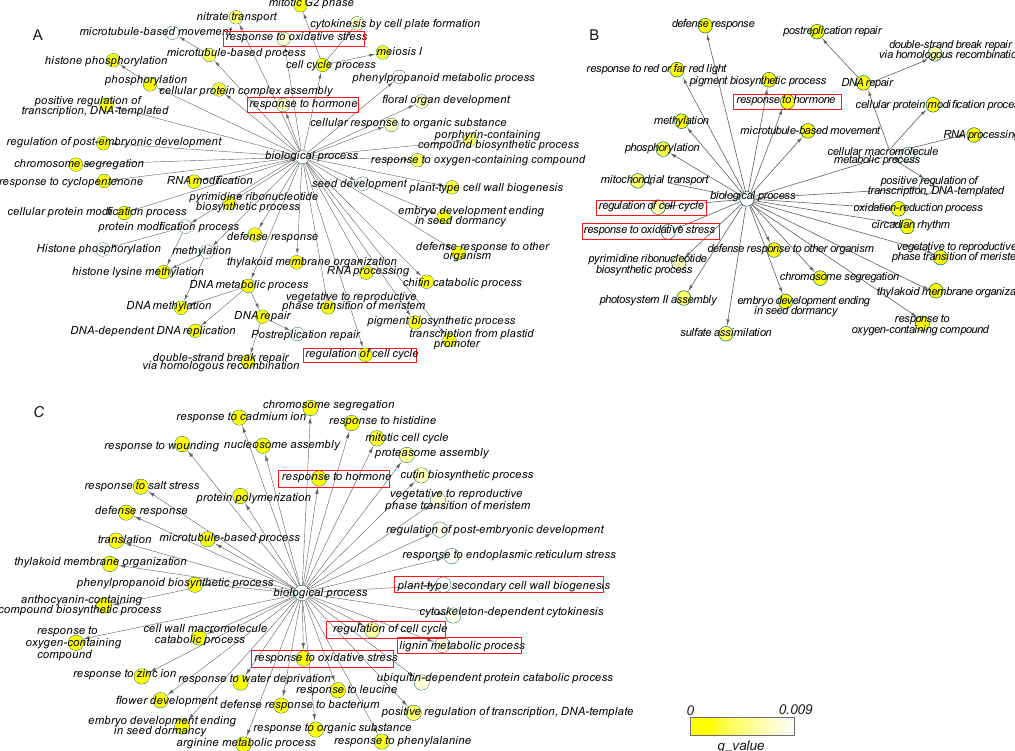
Figure 2. GO enrichment of DEGs during the graft process. ( A ) Significantly enriched GO terms between 8 days and 0 days; ( B ) significantly enriched GO terms between 15 days and 0 days; ( C ) significantly enriched GO terms between 30 days and 0 days. Bubbles represent the significant GO terms, and the bubble color gradient represent the magnitude of enrichment corresponding to q -values.